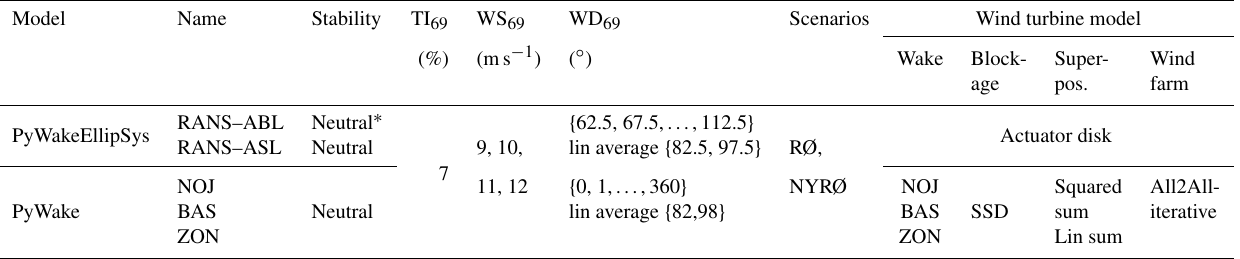
Table 5. Simulated flow cases with the high-resolution wake models in terms of wind speed (WS), wind direction (WD) and inflow turbulence intensity (TI) at 69m height. For scenario and wake model description see Sects. 2.2.1 and 2.2.2. ∗ RANS–ABL simulations are only approximately neutral (for details see Sect. 2.2.1). Linear is abbreviated